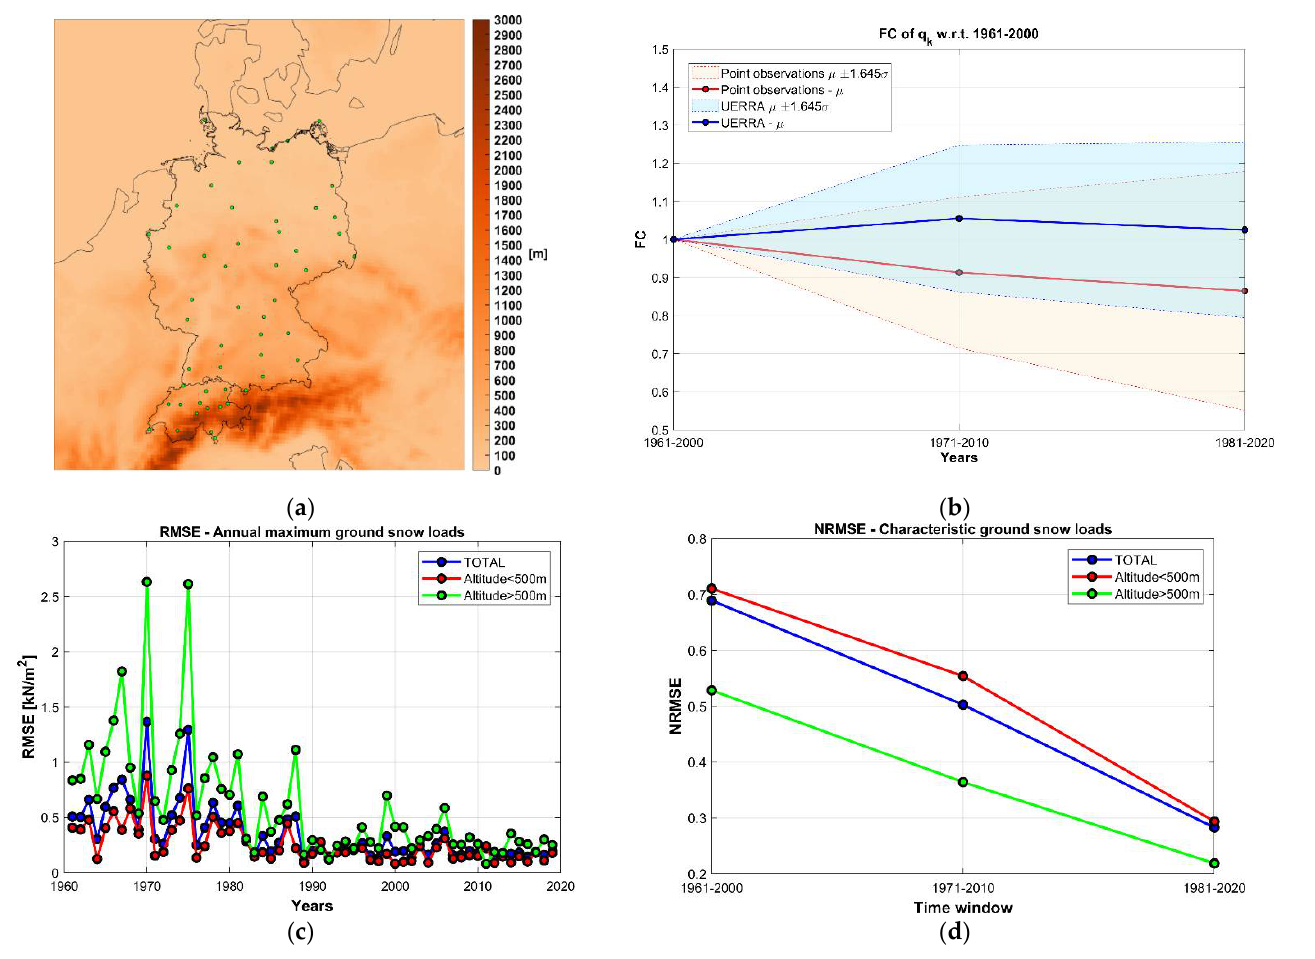
Figure 15. Point locations of the 51 test stations ( a ), factors of change for characteristic ground snow load ( b ), root-mean-square error (RMSE) values for annual maxima ground snow loads ( c ) and normalized root-mean-square error (NRMSE) values between characteristic ground snow loads obtained by the gridded re-analyzed data and recorded values at those stations ( d ).